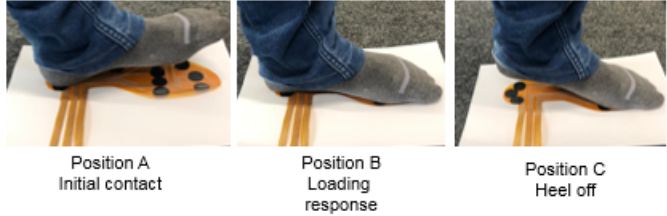
Figure 12. Positions in stationary phase.